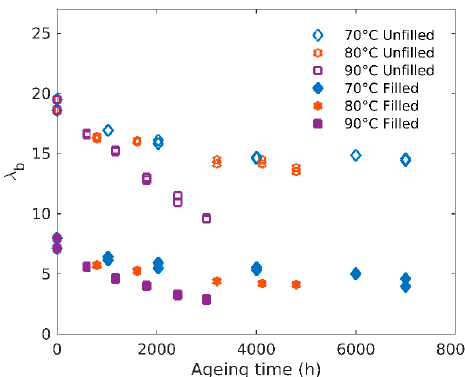
Figure 6. Evolution of the elongation at break with ageing time.